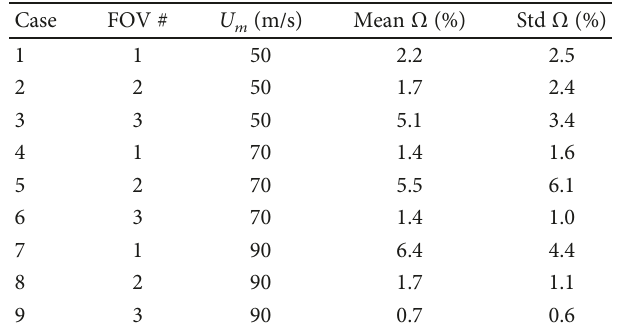
Table 3: Discrepancy between measured and theoretical droplet trajectories for the 9 cases of Table